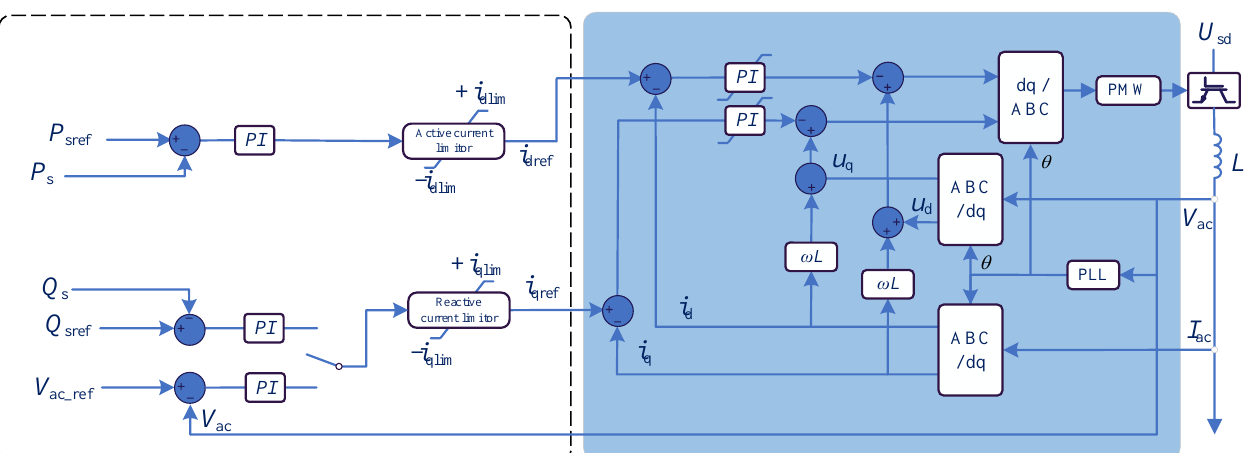
Figure 1. The structure of IPFC.